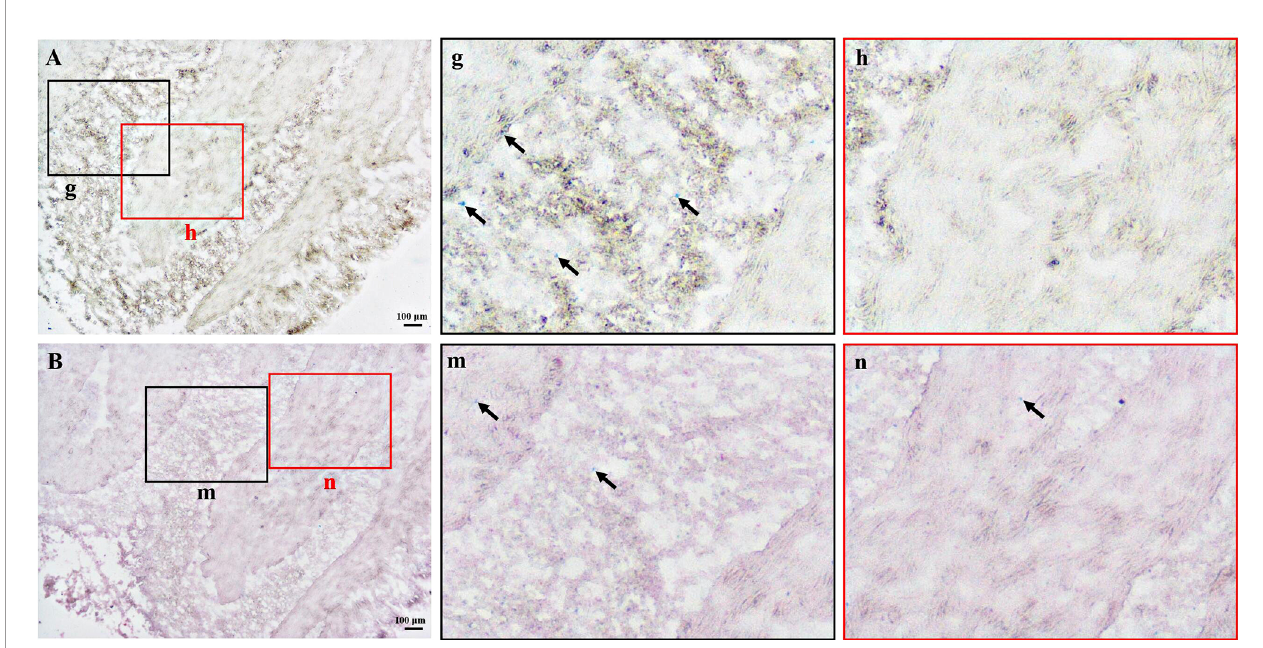
FIGURE 4 | Ferrous sulfate staining of melanin in frozen-sectioned mantle tissue. (A) Ferrous sulfate staining of melanin in mantle tissue with (B) and without (A) nuclear fast red counterstaining. The enlarged area in the black and red boxes corresponding to Figure A or B (g, h, m, n). The green areas (arrow) represent positive results. Bar, 100 m